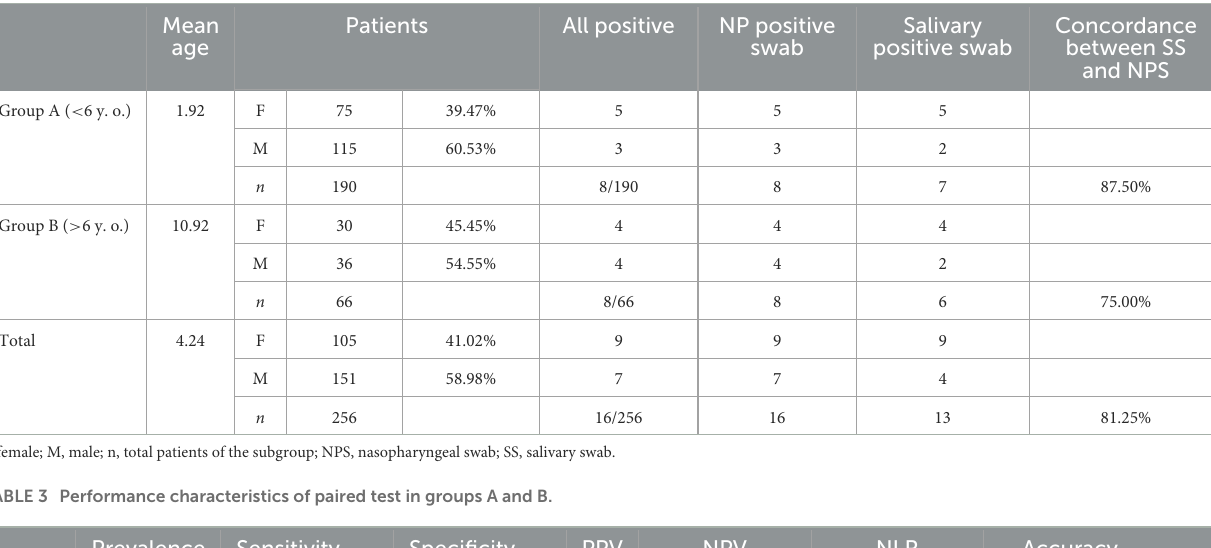
Salivary Concordance swab positive swab between SS and NPS